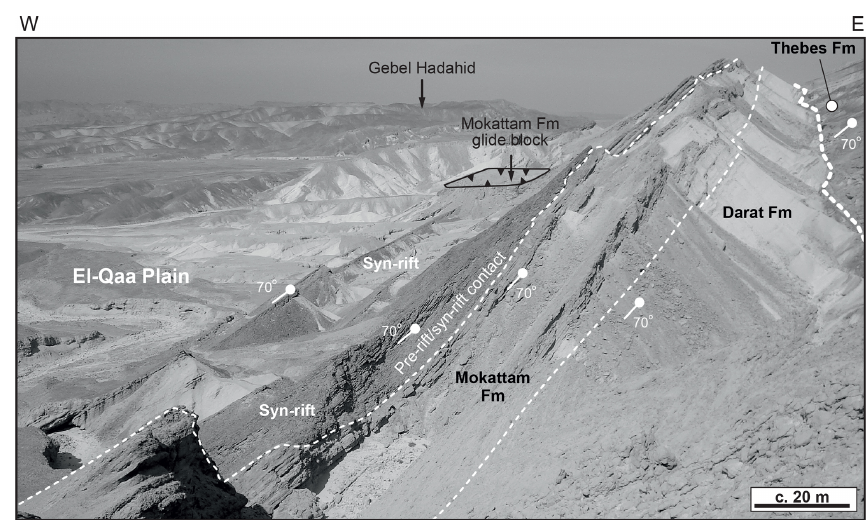
Figure 15. Photograph looking northwards along the Hadahid Monocline Segment. Note the angular discordance of ca. 10 ◦ between the pre-rift (Mokattam Formation) and overlying syn-rift strata (Nukhul Formation) (see Lewis et al., 2015). Location of the photo is shown in Fig.